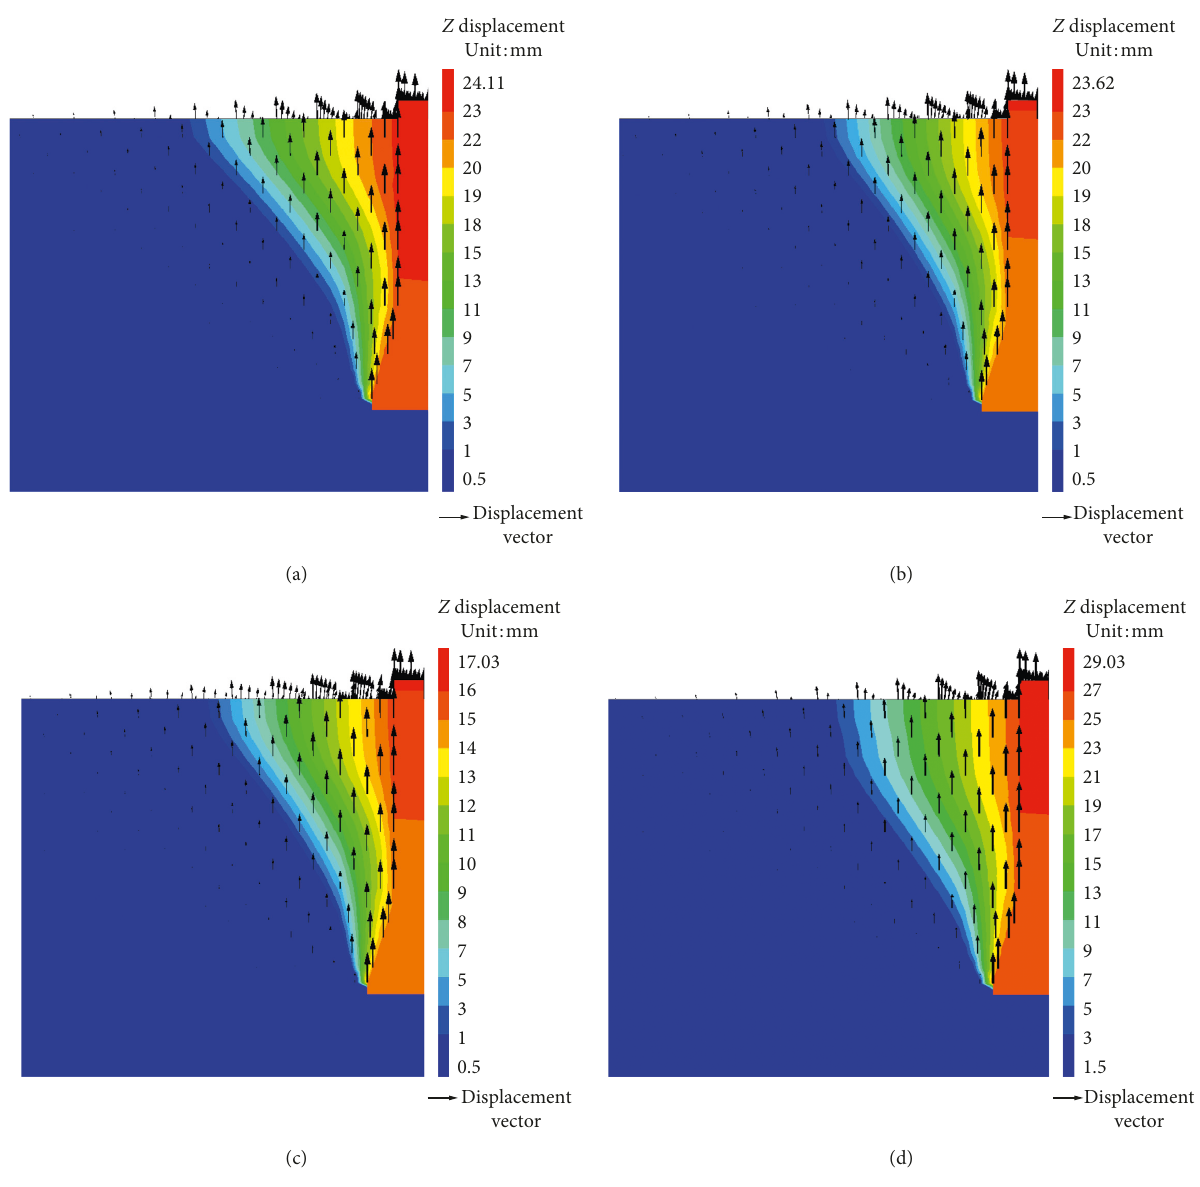
Figure 21: The calculated failure plane. (a) Test I. (b) Test II. (c) Test III. (d) Test